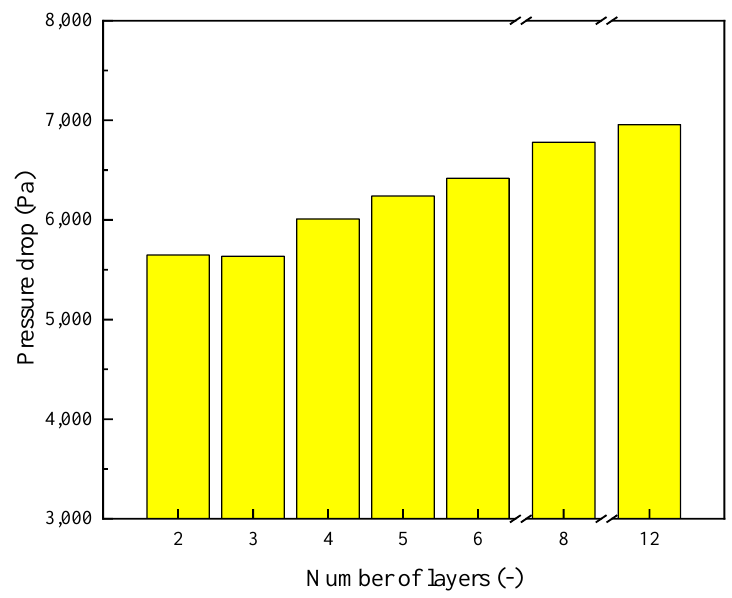
Figure 12. Pressure drop comparison for a different number of layers.